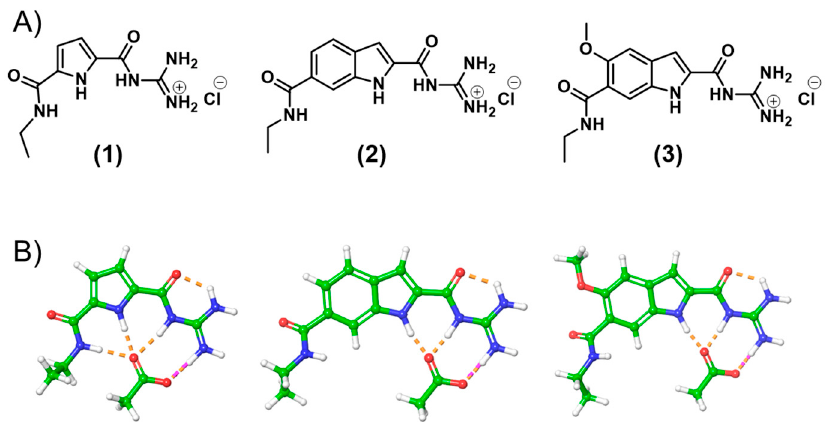
Figure 2. ( A ) Molecular structures of GCP ethyl amide ( 1 ), GCI ethyl amide ( 2 ), MGCI ethyl amide ( 3 ). ( B ) calculated lowest energy structure of complexes of ( 1 ), ( 2 ) and ( 3 ) with acetate anions, force field calculations (MacroModel V12.4, OPLS 2005 force field, conformational search, in water, mixed torsional/low-mode sampling). Ionic interactions are depicted in pink, H-bonds in orange.